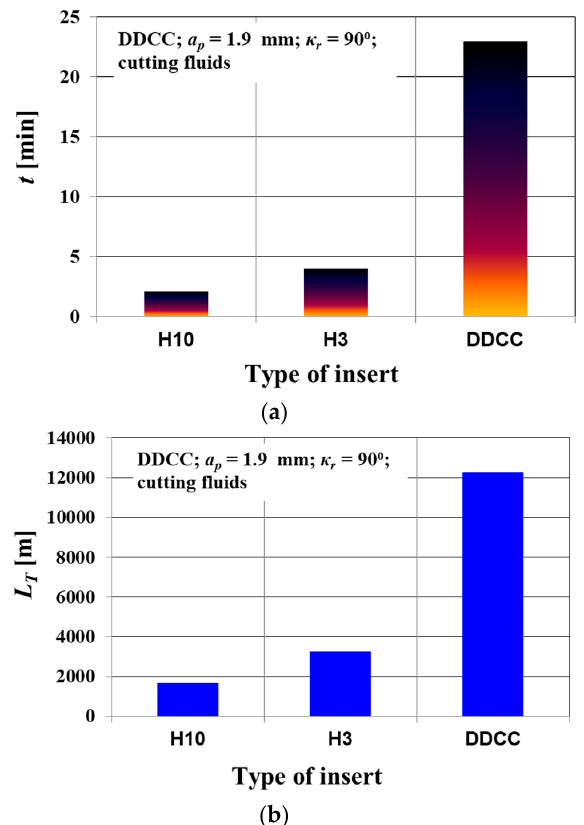
Figure 10. Durability of tested cutting inserts within the range of v c = 800 m/min, f = 0.15 mm/rev: ( a ) comparison of the tool life of DDCC, H3 and H10 cemented carbides; ( b ) cutting path over the tool life for DDCC, H3 and H10 cemented carbides.